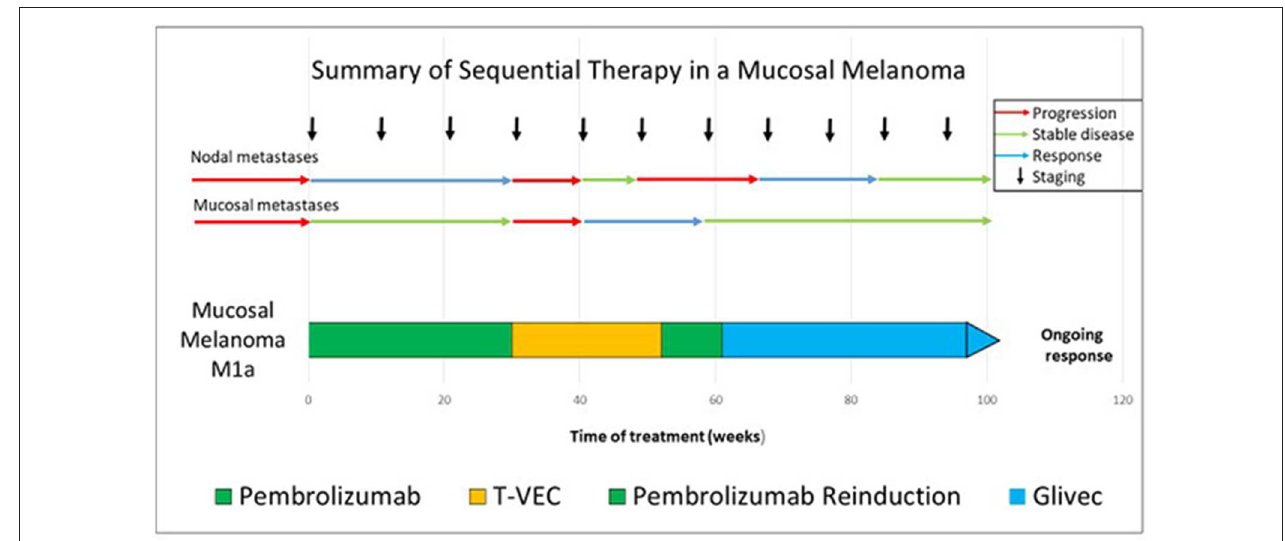
FIGURE 3 | Summary of the sequential treatment in our case of advanced mucosal